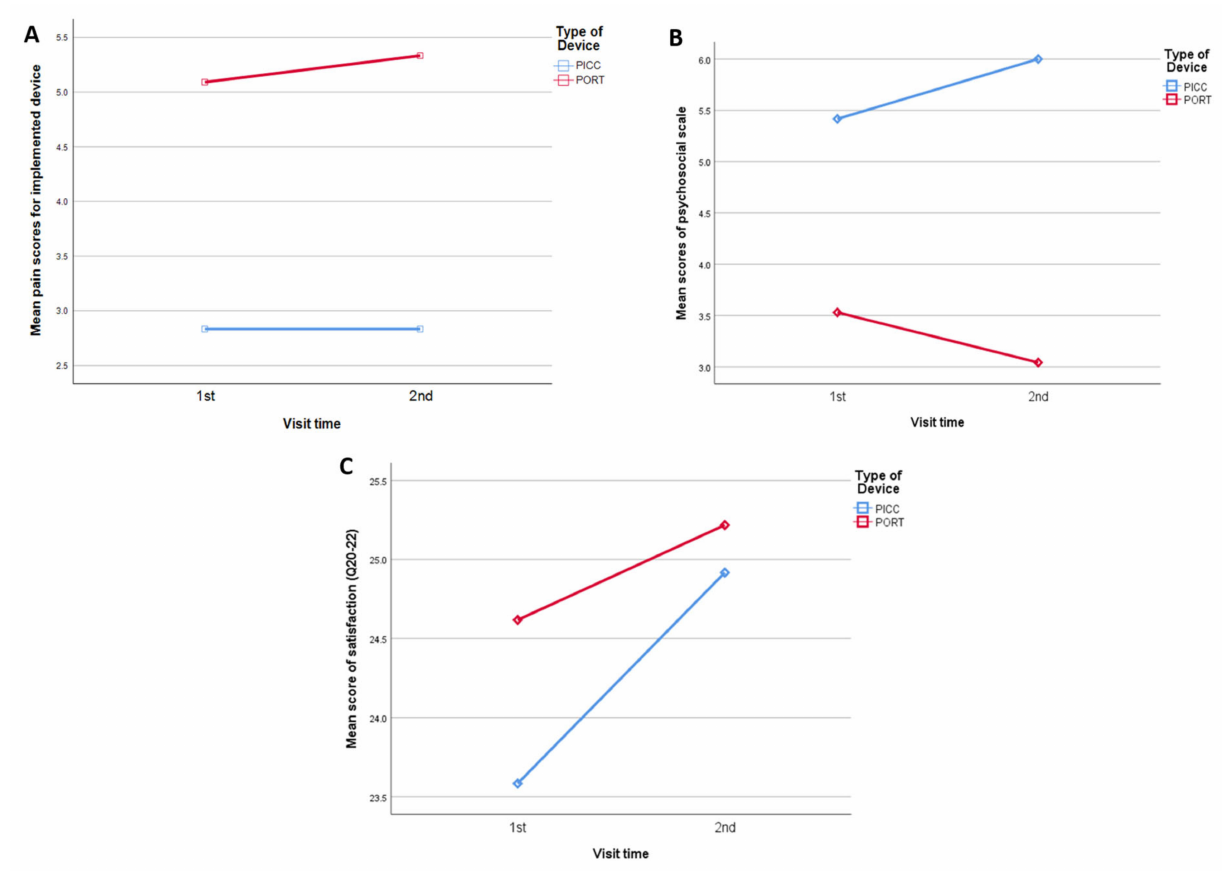
Figure 1. Comparison of QLVAD scores between patients with port and PICC devices: ( A ) patients with a port had high pain scores compared with patients with a PICC line; ( B ) patients with a PICC line experienced higher negative psychosocial scores; ( C ) both patients with a PICC and port had high satisfaction scores with their devices at 0 and 3